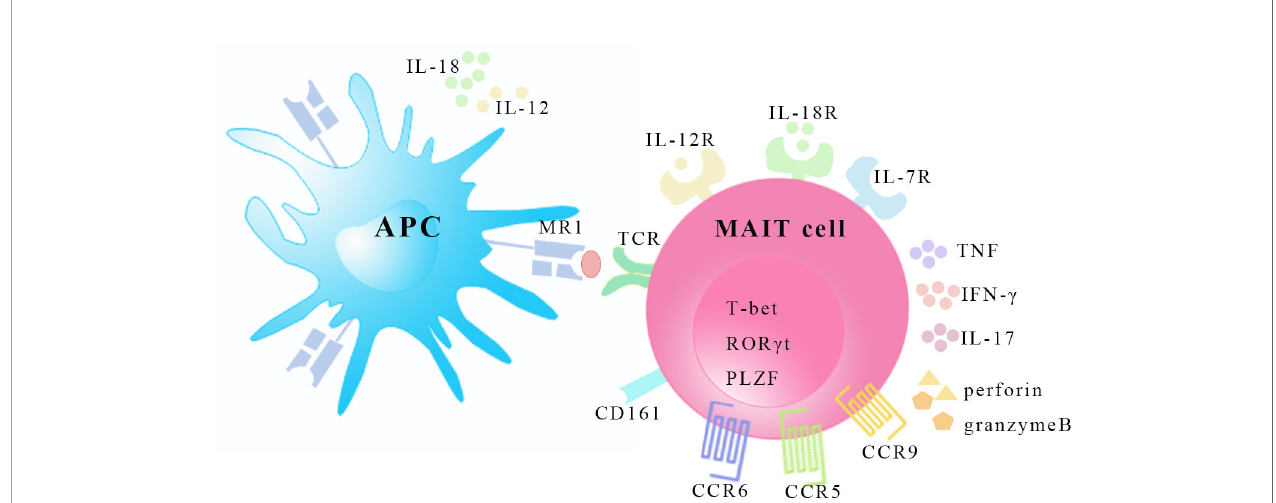
FIGURE 1 | The characteristics of MAIT cells. MAIT cells recognize ribo fl avin-derived antigens presented by MR1 on surface of antigen presenting cell. MAIT cells express homing receptors CCR5, CCR6 and CCR9, and possess transcription factors T-bet, ROR g t, and PLZF. MAIT cells can be activated in a TCR-dependent manner and cytokine-mediated manner by in fl ammatory cytokines like IL-12, IL-18 and IL-7. In response, MAIT cells secret Th1 and Th17 type cytokines and release granzyme B and perforin. APC, antigen presenting cell. MR1, major histocompatibility complex class 1-related molecule; TCR, T-cell receptor; CCR, CC-chemokine receptor; T-bet, T-Box transcription factor TBX21; ROR g t, retinoic-acid-related orphan receptor g t; PLZF, promyelocytic leukemia zinc fi nger; IL, interleukin; TNF, tumor necrosis factor, IFN- g , interferon- g